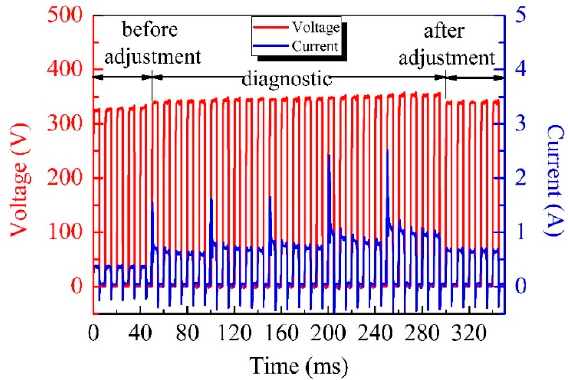
Figure 3. Voltage and current waveforms of pulses during a typical self-adaptive adjustment process.